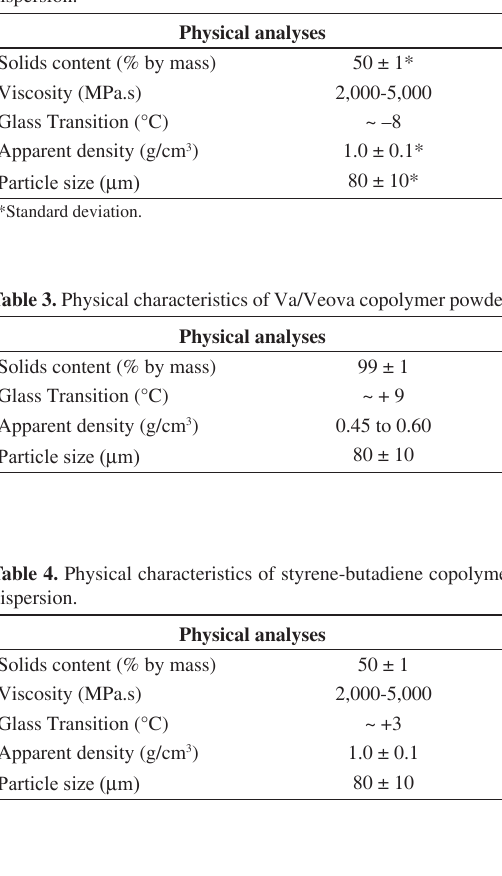
Table 5. Chemical analysis of carbonate filler. Element